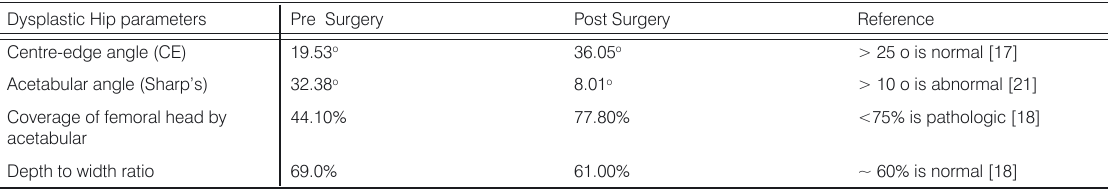
Table 1. Dysplastic Hip Morphological Measurements based on patient’s CT scan